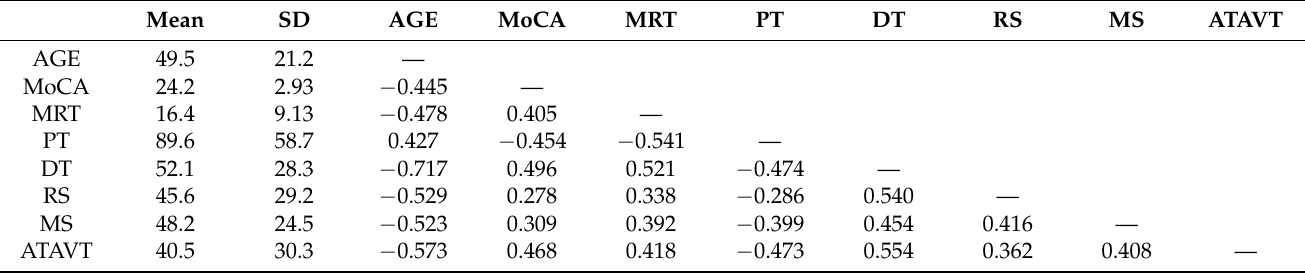
Table 1. Means, standard deviations, and correlations between variables used in path analysis. MoCA: Montreal Cognitive Assessment, MRT: Mental Rotation Test, PT: Perspective-Taking, DT: Determination Test, RS: Reaction Speed, MS: Motor Speed; ATAVT: Adaptive Tachistoscopic Traffic Perception Test. All correlations are significant, p <